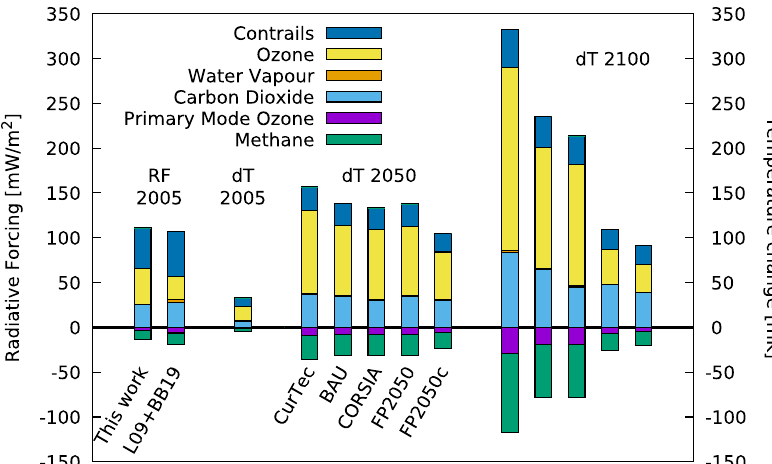
Fig. 3 Break-down of aviation ’ s climate impact into climate agents (colour). The individual bars are grouped into four categories. (1) The two bars on the left describe the radiative forcing of aviation in the year 2005 (RF 2005). Results from Lee et al. (2009) are expanded by contrail-cirrus estimates based on Bock and Burkhardt (2019), denoted by L09 + BB19, respectively; (2) temperature change in the year 2005 (dT 2005); (3) temperature change in the year 2050 for the 5 scenarios (dT 2050); (4) as (3), but for the year 2100 (dT 2100). For 2100, i.e. the right-hand columns, the scenarios are presented in the same order as for 2050. The order in the legend is the same as the colours appear in the individual boxes. The scenarios describe a future use of current